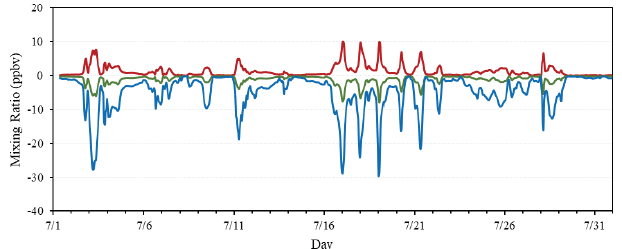
Figure 9. The difference of O 3 mixing ratios between the standard V d run and runs with V d × 10 − 5 (red), × 2 (green) and × 10 (blue) at Oki in July 2010 by